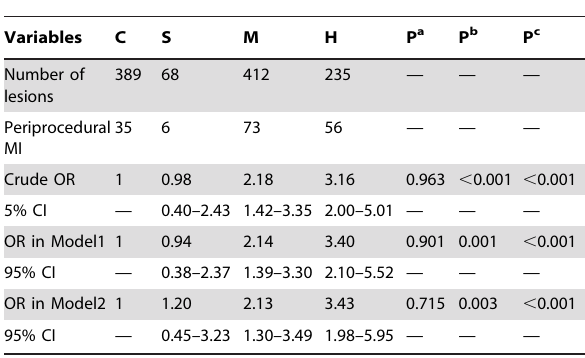
Abbreviations were as followed in Table 2.